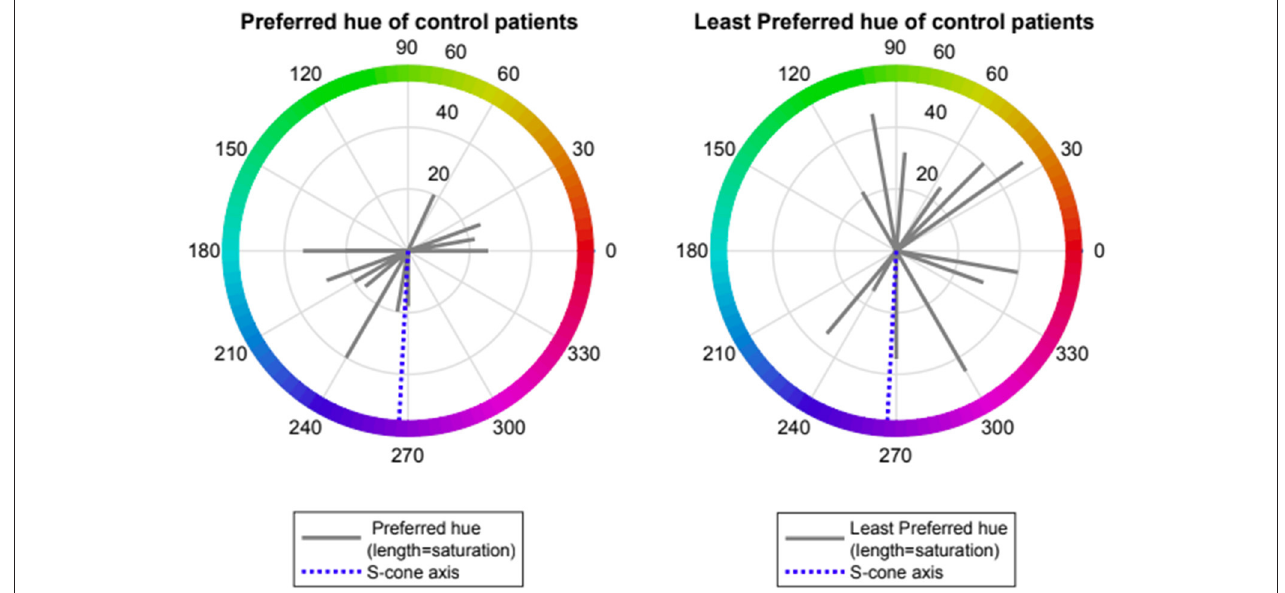
FIGURE 1 | Preferred and Least preferred hue of control participants expressed as angle in CIE 1976 LUV space (red lines); dotted blue line represents the Tritanopic confusion line.